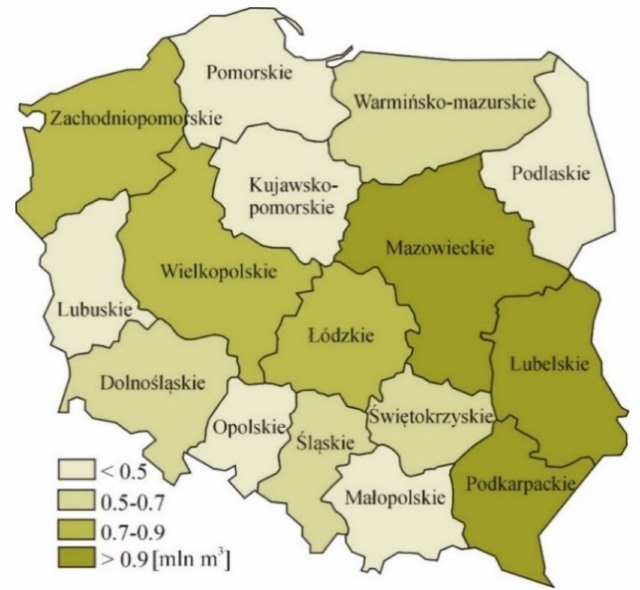
Figure 8. Volume of BM that can be obtained annually from maize silage cultivated in idle land and waste land in Poland (mln m 3